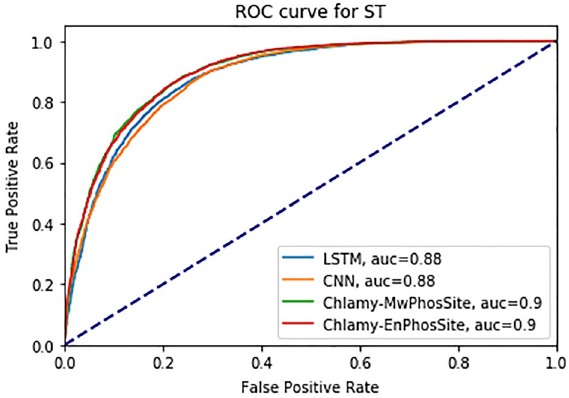
Figure 6. ROC curve for different DL models for S and T